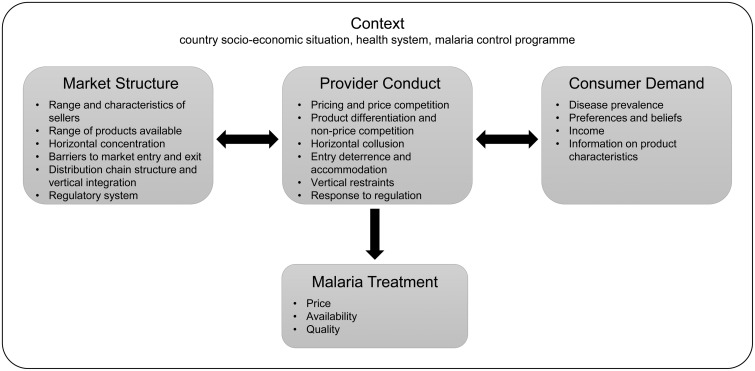
Structure, conduct, performance analytical framework (Goodman 2004; Patouillard 2012)